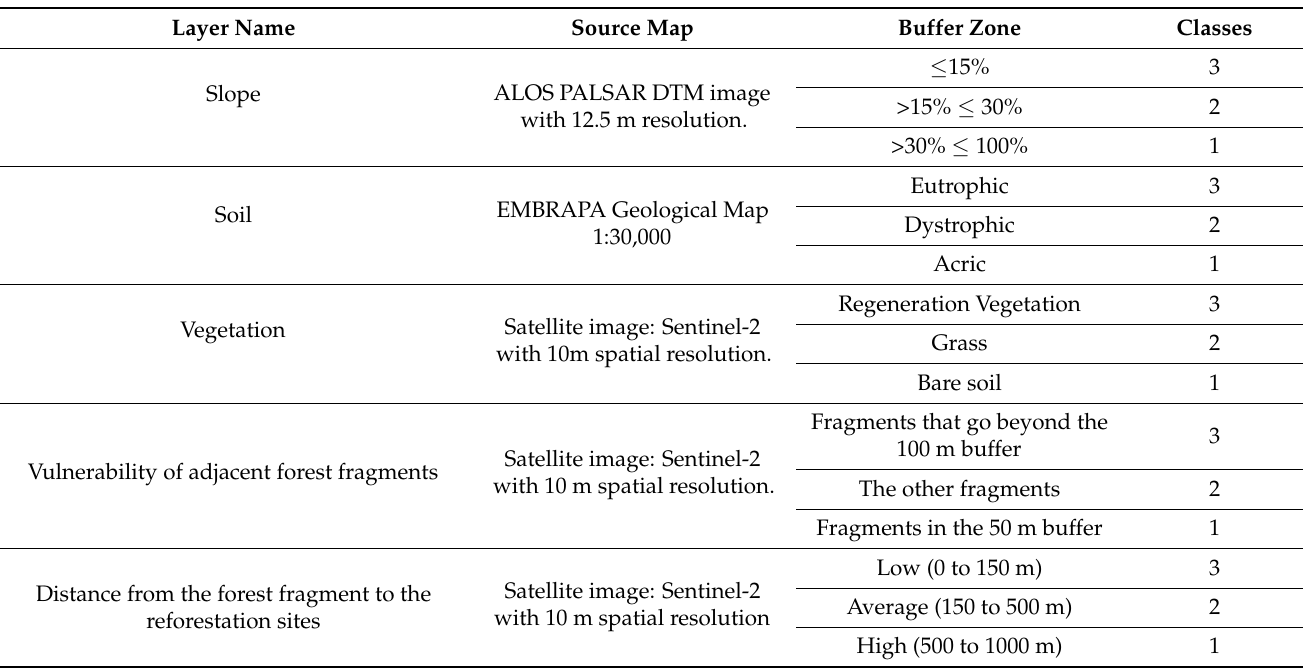
Table 2. Summary of the input